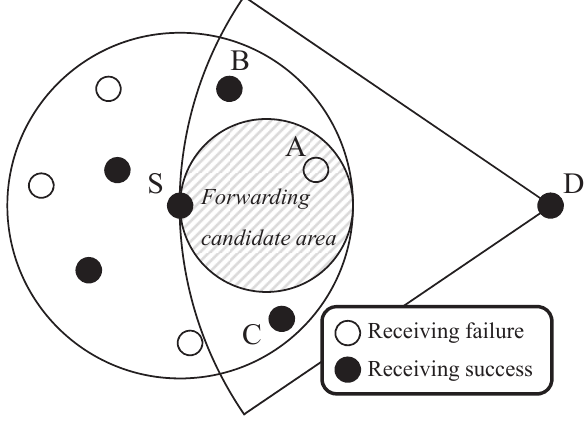
Figure 1. An example of next-hop forwarder selection failure in the restricted forwarding area-based beaconless routing